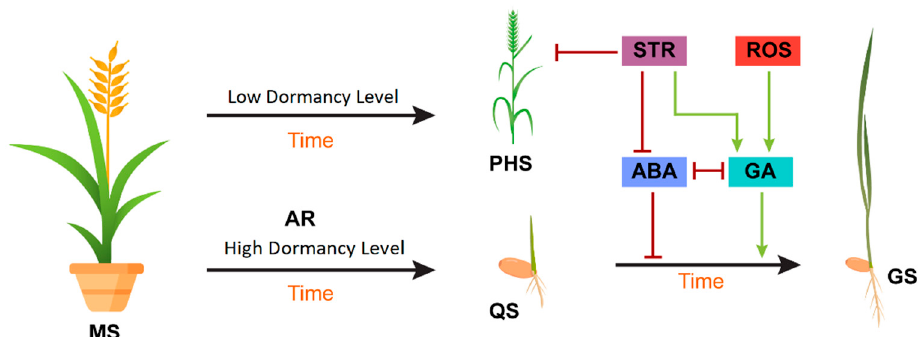
Figure 2. Model showing the effects of extrinsic and intrinsic factors on seed dormancy and germination. During the maturation of the seed (MS), intrinsic ABA is upregulated, and GA is downregulated to inhibit preharvest sprouting (PHS) on the mother plant. After harvest, stratification (STR) and reactive oxygen species (ROS) increase GA biosynthesis and repress ABA biosynthesis, turning the quiescent seed (QS) into a germinating seed (GS). Red bars indicate an inhibition effect, whereas green arrows indicate a promotion effect.